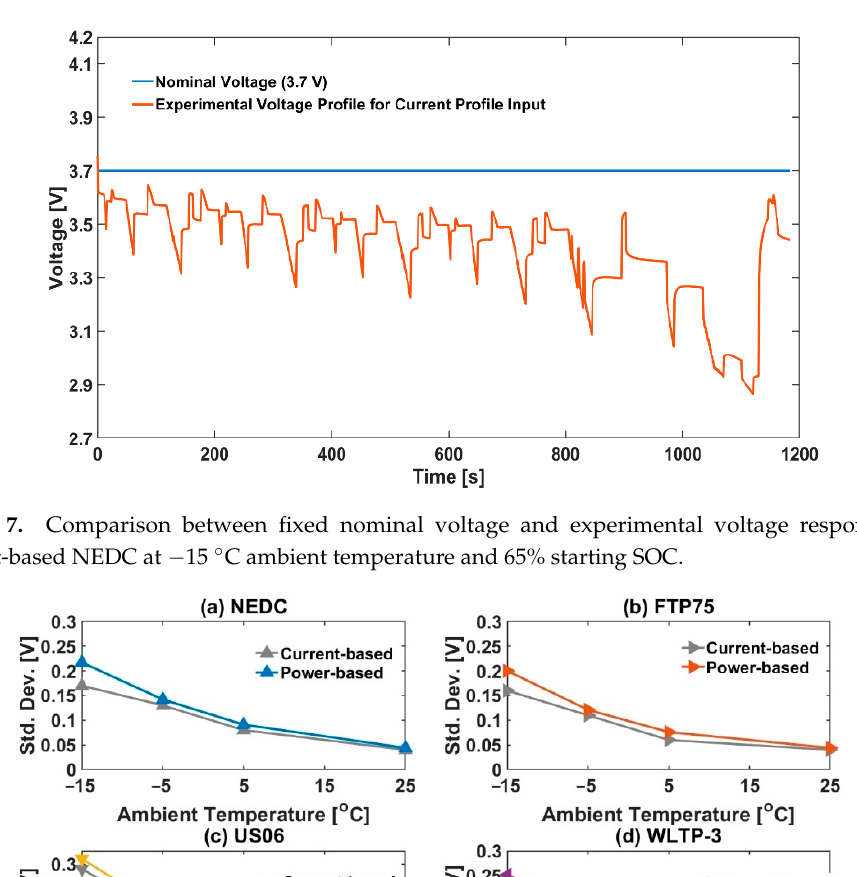
Figure 7. Comparison between fixed nominal voltage and experimental voltage response for current- based NEDC at − 15 °C ambient temperature and 65% starting SOC.